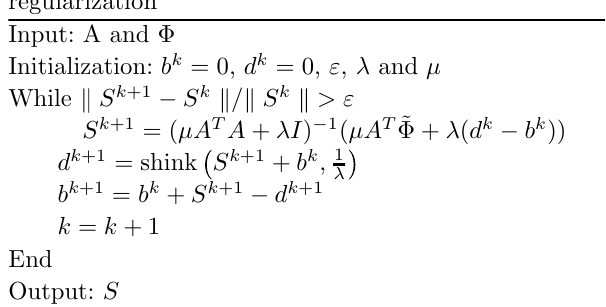
Algorithm 1 Split Bregman iterative method with L1